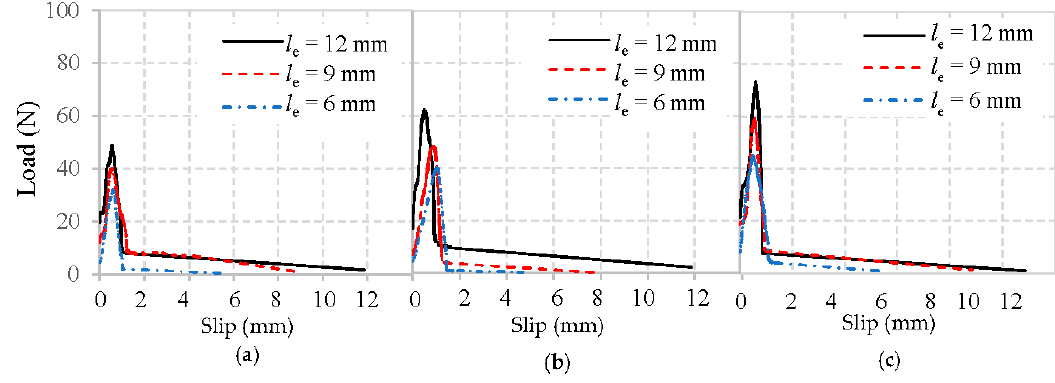
Figure 11. Load–slip curves of glass fibers pulled out from mortar matrix: ( a ) W / C = 0.65, ( b ) W / C = 0.49, and ( c ) W / C = 0.40.